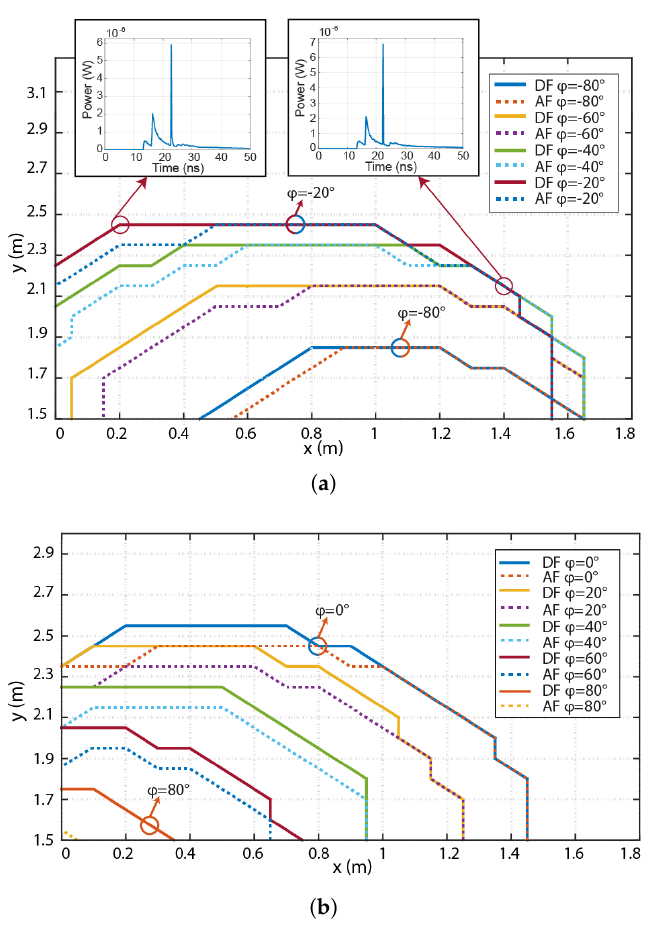
Figure 7. Azimuthal dependency of the RN with an elevation angle of 5 ◦ with RN oriented toward the: ( a ) right wall; and ( b ) left wall. Curves show the borders where the RN can be used and ensures a BER of < 10 –3 for the entire link. Insets in ( a ) illustrate impulse responses of the complete relay-assisted link.